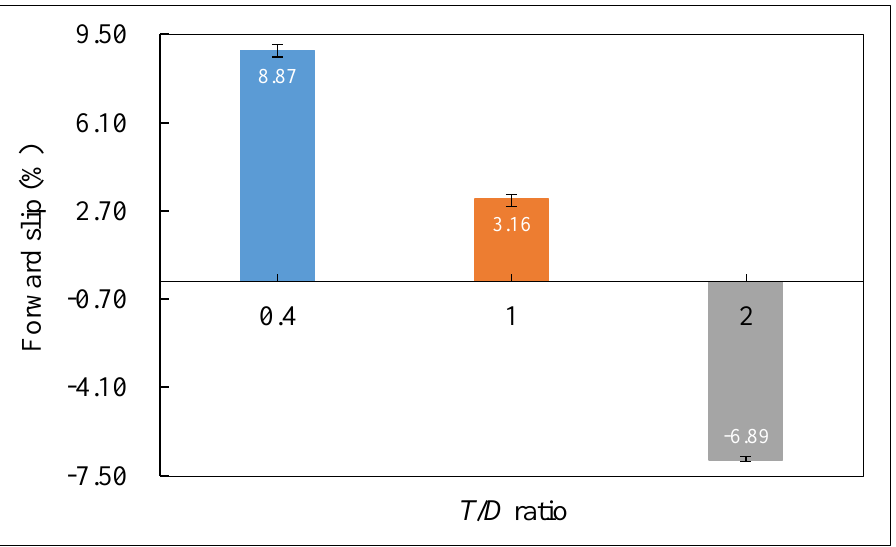
Figure 11. Tendency of forward slip with T / D ratio for the rolling phase with thinner thickness.